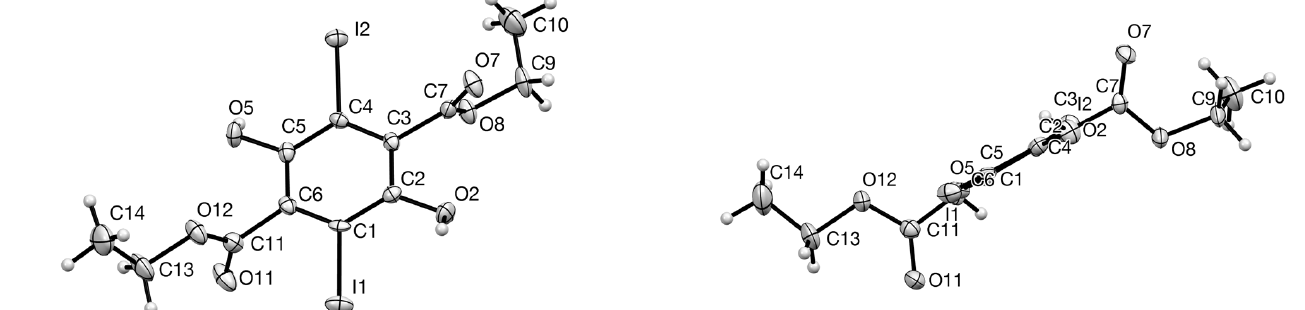
Figure 1. Two views of the molecular structure of 1 showing esters orthogonal to ring (thermal ellipsoids at 50% level). Bond lengths C(1)–I(1) 2.096(3), C(4)–I(2) 2.094(3) Å; torsion angles C(5)–C(6)–C(11)–O(12) –92.6(4), C(2)–C(3)–C(7)–O(8) 109.9(3).